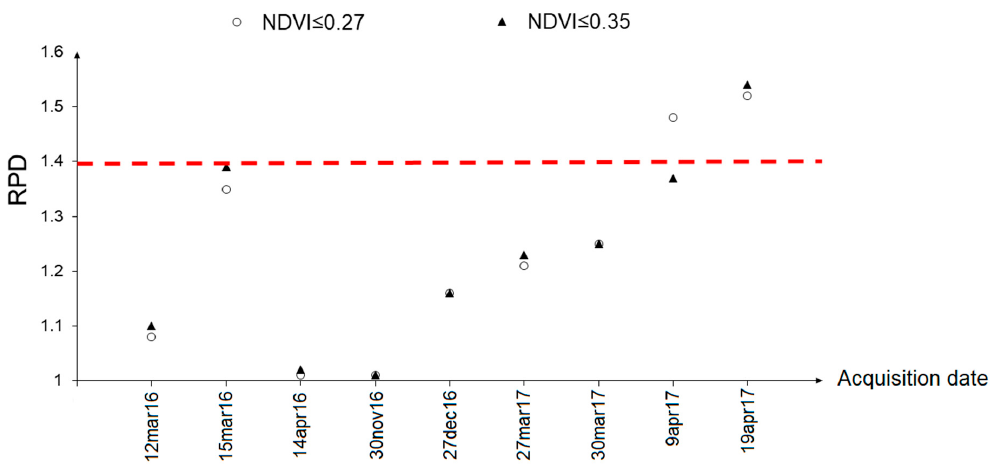
Figure 4. Influence of an NDVI threshold on residual prediction deviation (RPD).